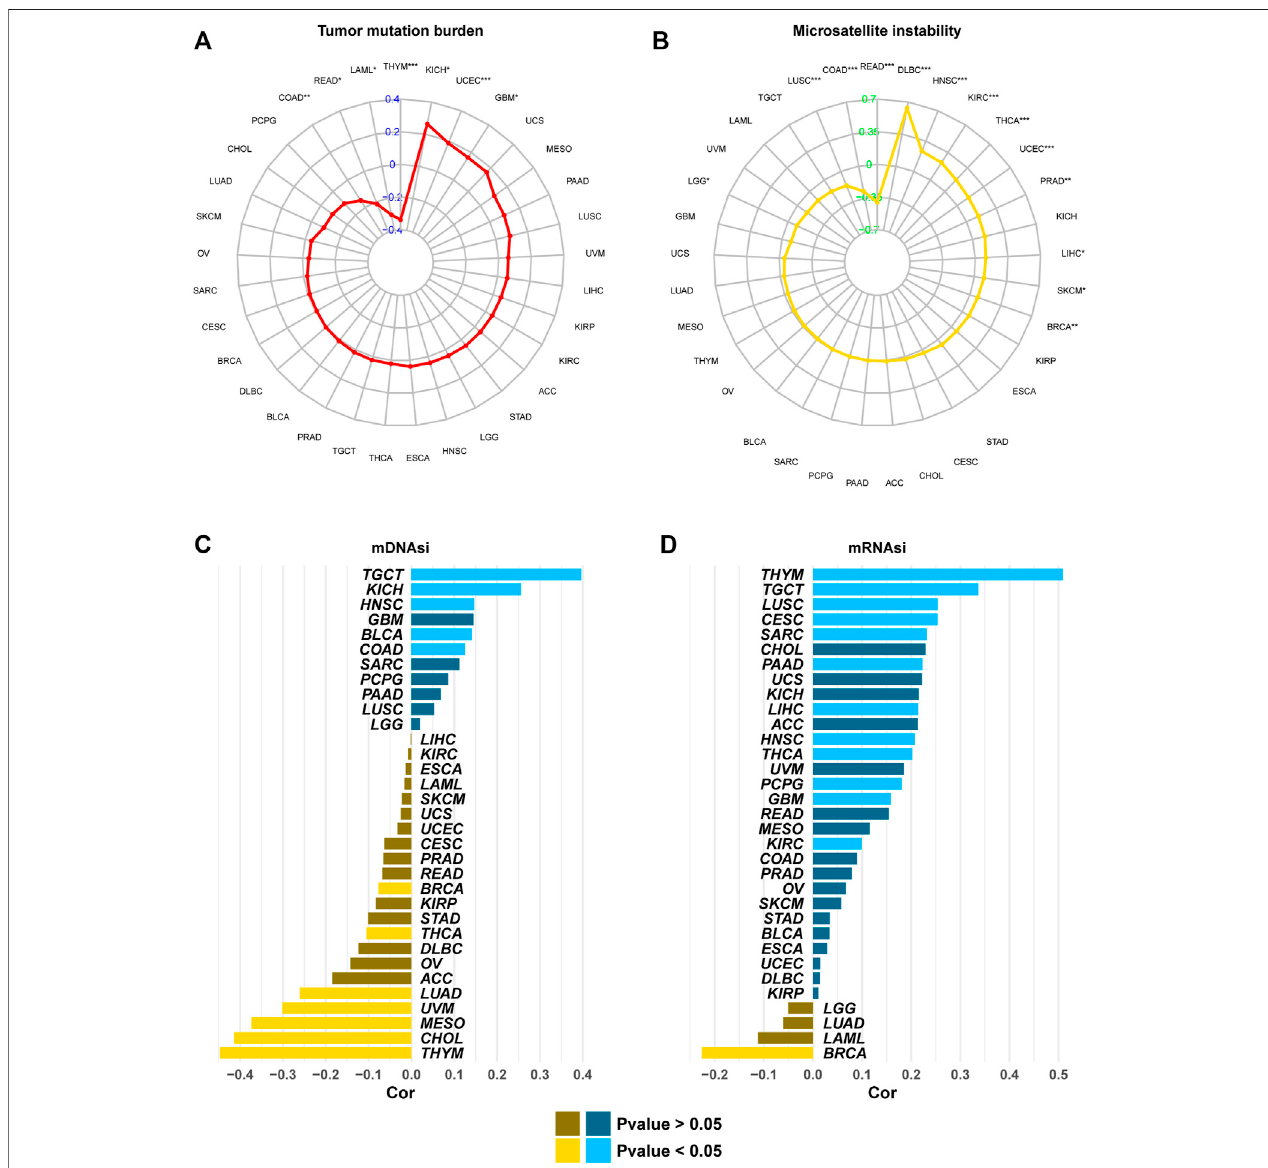
FIGURE9| ThecorrelationbetweenALKBH7expressionandtheTMB (A) ,MSI (B) ,mDNAsi (C) ,andmRNAsi (D). “ * ” indicates p < 0.05, “ ** ” indicates p < 0.01and “ *** ” indicates p < 0.001.